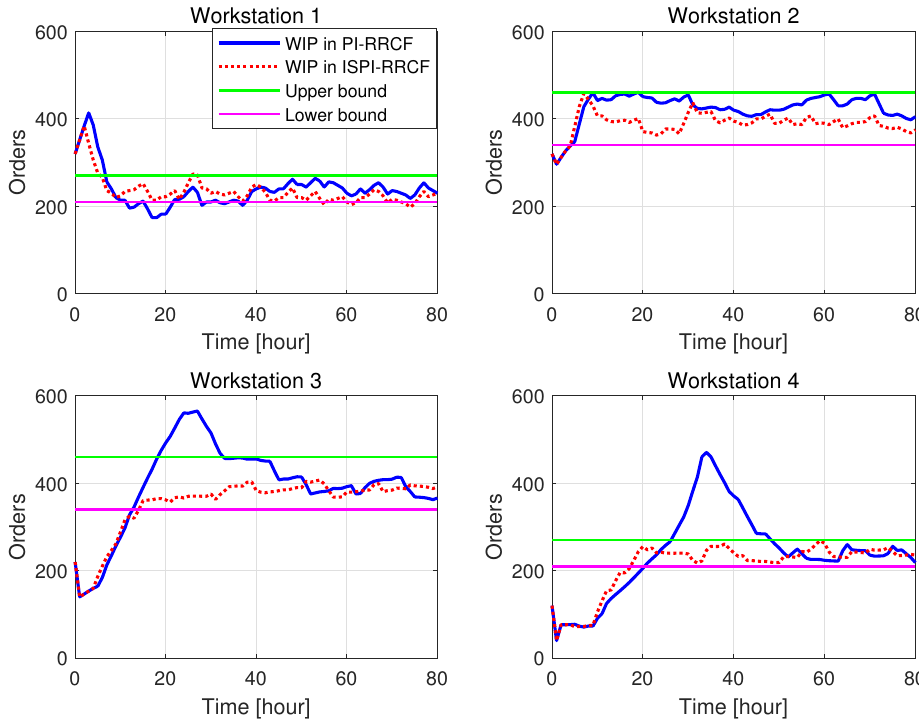
Figure 7. WIP levels of workstations for stochastic demands. Distribution of RMTs in PI-RRCF